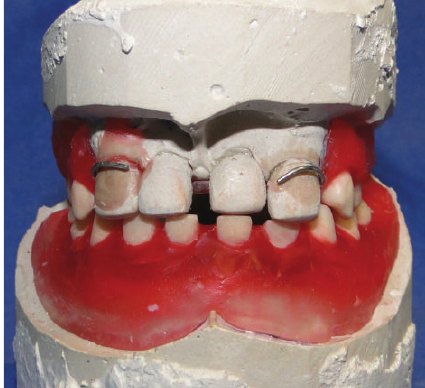
Figure 8: Frontal view of the casts mounted in a simple articulator with artificial teeth.